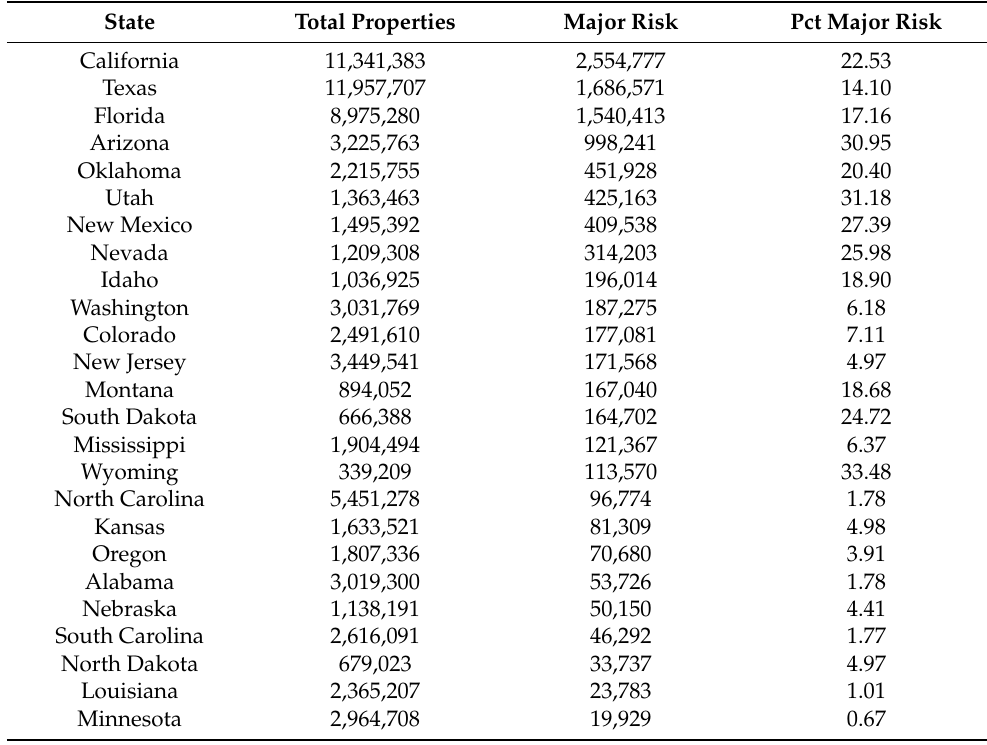
Table 4. Top 25 state ranking by “major risk” (cumulative burn probability of